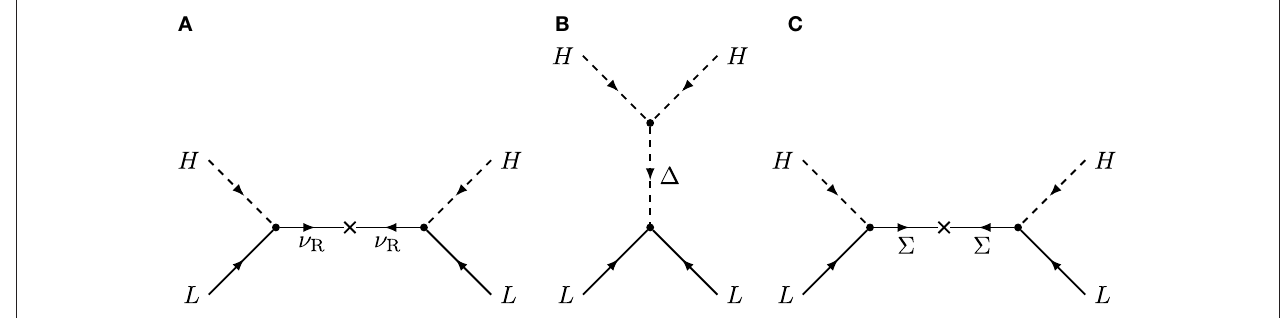
FIGURE 2 | Minimally opening up the Weinberg operator at tree-level using either exotic massive fermions or scalars. (A) Type-I seesaw model. The massive exotic particle integrated out to produce an effective Weinberg operator at low energy is a SM gauge-singlet Majorana fermion, the right-handed neutrino ν R . (B) Type-II seesaw model. The massive exotic is a (1,3, 1) scalar 1 coupling to LL and H † H † . It gains a small induced VEV from the latter coupling. (C) Type-III seesaw model. The massive exotic is a (1,3,0) fermion 6 whose middle component mixes with the left-handed